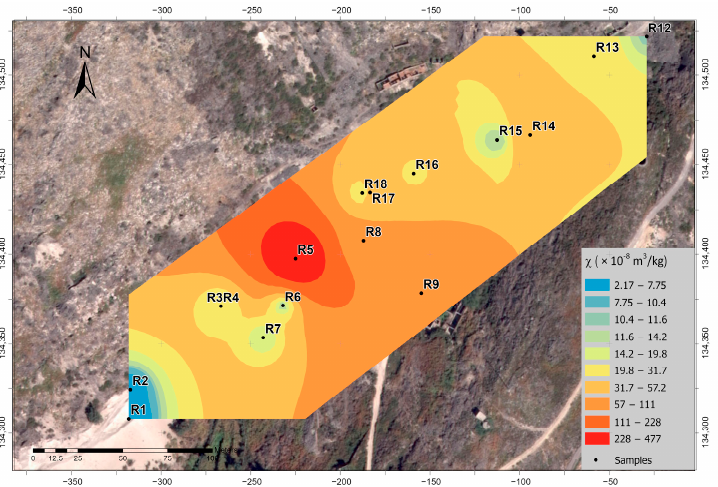
Figure 10. Mass magnetic susceptibility map of the mining area (magnetic susceptibility data inter- polation made by inverse distance weighting in the ArcGIS PRO software, ESRI).